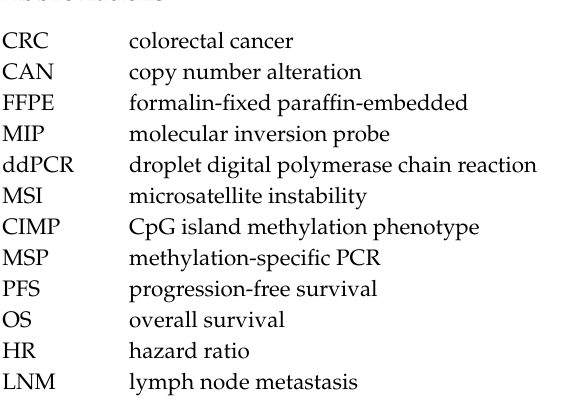
Figure S1: Depressed neoplasm has invasive cancer at small-size stage, Figure S2: Copy number alterations in depressed and polypoid neoplasms, Figure S3: Arm-level changes in MYC, CCNA1, and BIRC7 in each case in the discovery set, Table S1: Matched protein coding genes with significant arm-level changes in chr8, chr13, and chr20, Table S2: Diagnostic performance of the D-mark panel for detecting depressed